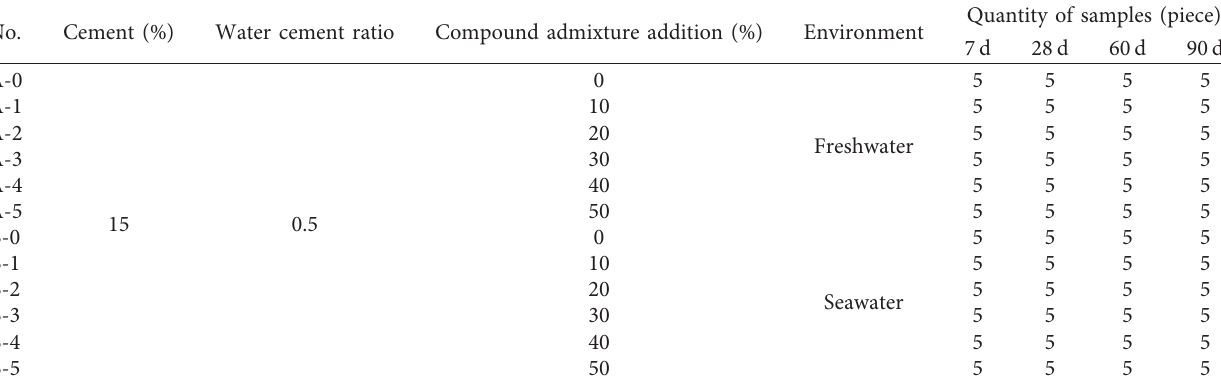
Table 5: Unconfined compressive strength test.